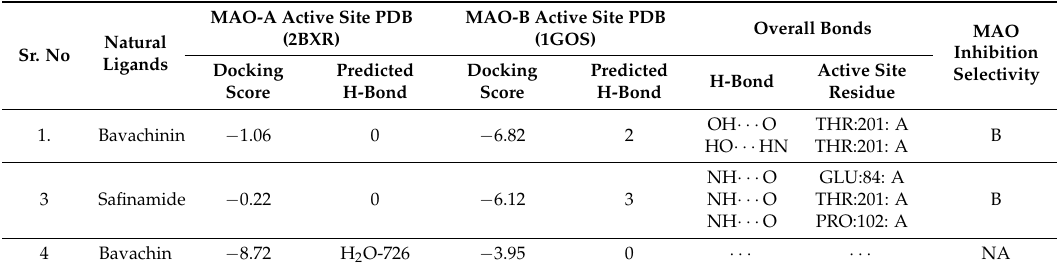
Table 4. Inhibition affinity by docking studies, of MAO isoforms by flavanones of Psoralea corylifolia extract.